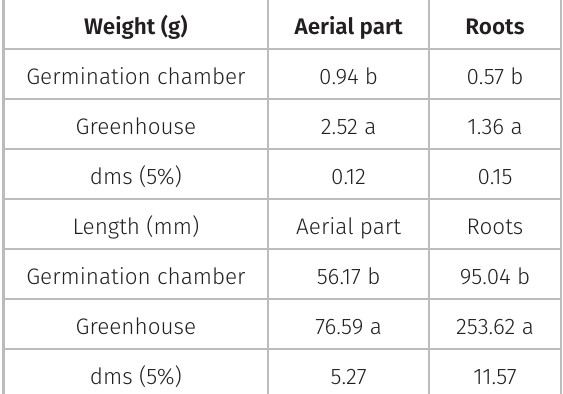
Table III. Length (mm) and weight (g) of the root and aerial parts of seedlings maintained in a germination chamber or greenhouse, 30 days after germination.